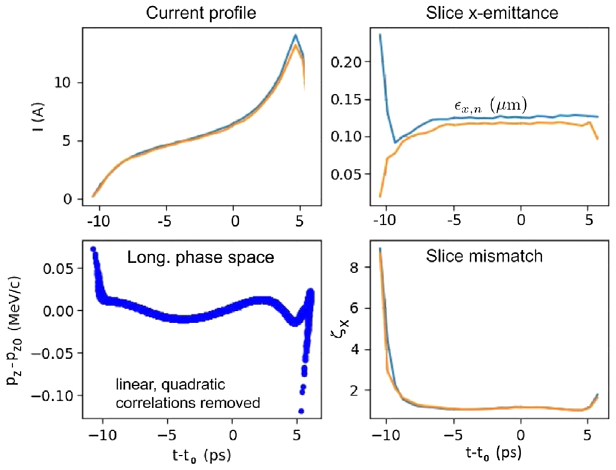
6. High resolution simulation using ASTRA with 250k macroparticles showing details of a particular 100 pC solution selected from the optimization front shown in Fig. 5 for the double-cell APEX-2 configuration case. The blue and orange curves indicate the results for 100% and 95% of the particles